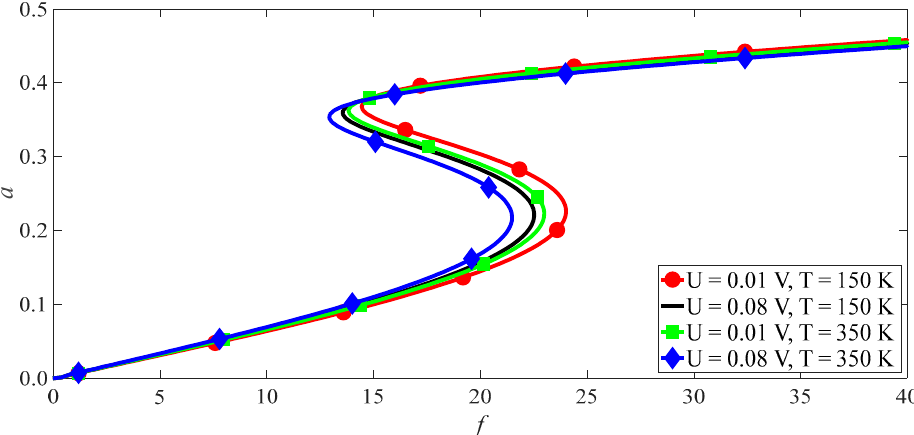
Figure 8. Excitation amplitude response curves of the first mode with